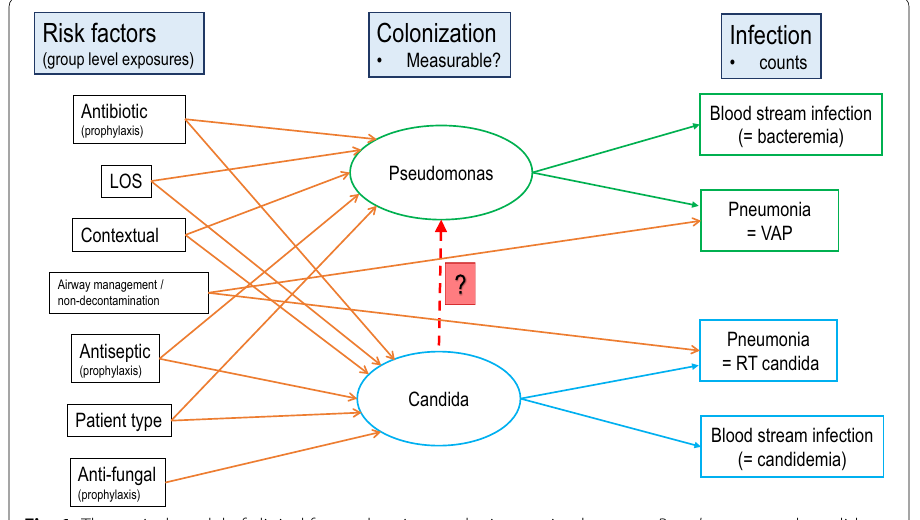
Fig. 1 Theoretical model of clinical factors bearing on the interaction between Pseudomonas and candida colonization towards causing blood stream and other infections. ‘contextual’ refers to the contextual effect within each ICU setting. The blue boxes label the elements required to address the central research question here depicted by the vertical arrow labelled ‘?’. This research question would not be easily addressed within a single center